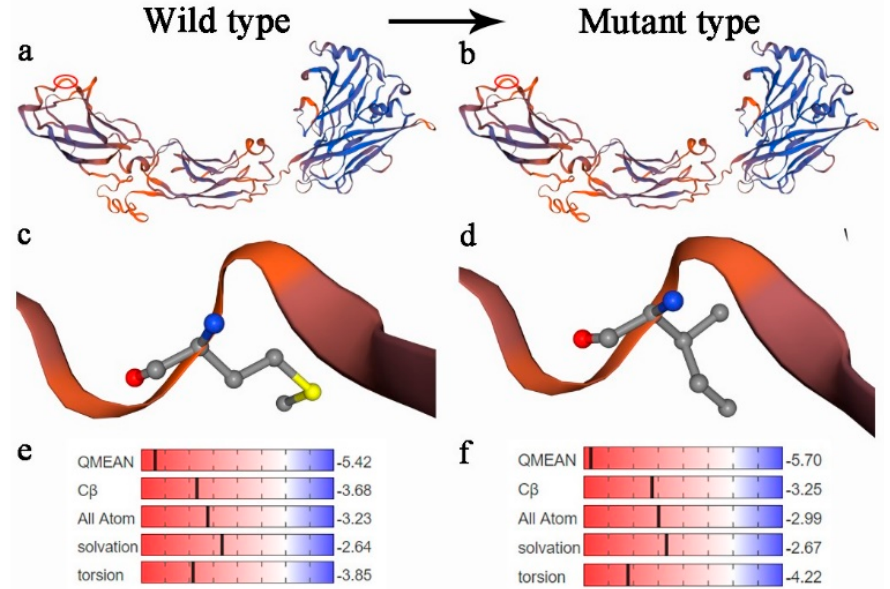
Figure 2. The 3D structure of the bovine RET gene was constructed using the SWISS-MODEL. Note: The predicted 3D structure of the bovine RET gene of the wild type ( a ) and the mutant type ( b ). The structure of Met ( c ) and Ile ( d ). the qualitative model energy analysis of the wild type ( e ) and the mutant type ( f ).